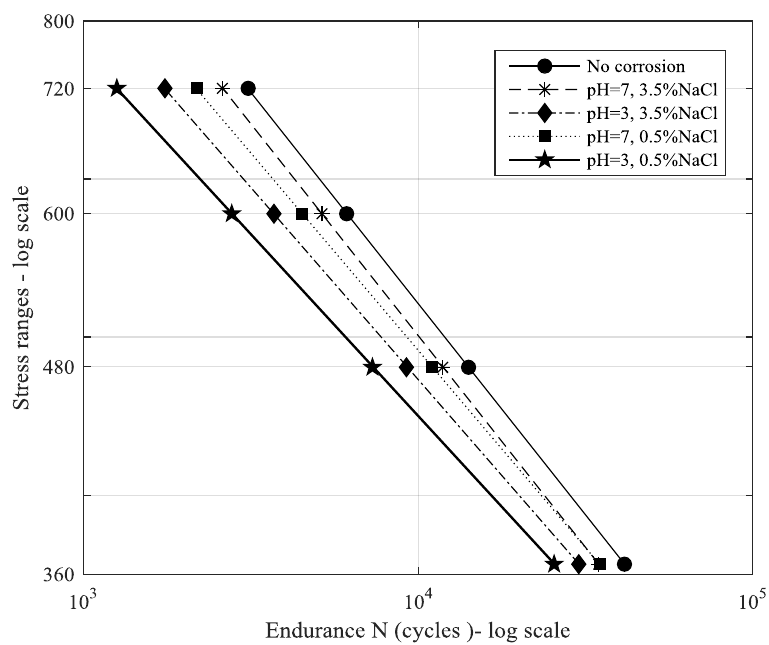
Figure 14. Logarithmic S-N curves of steel wire with machine-cut notch subjected to the fatigue load and sodium chloride solution.